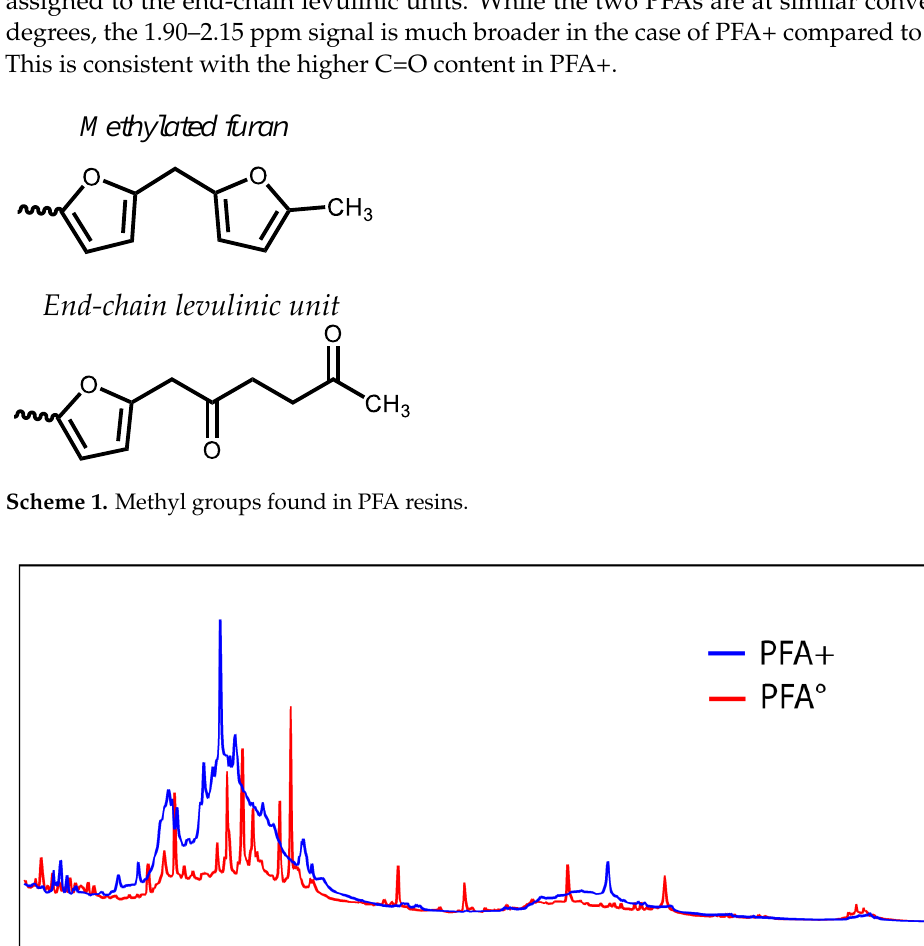
Figure 2. Magnified 1H NMR spectra of PFA° (red) and PFA+ (blue) at a conversion degree of about 0.80.